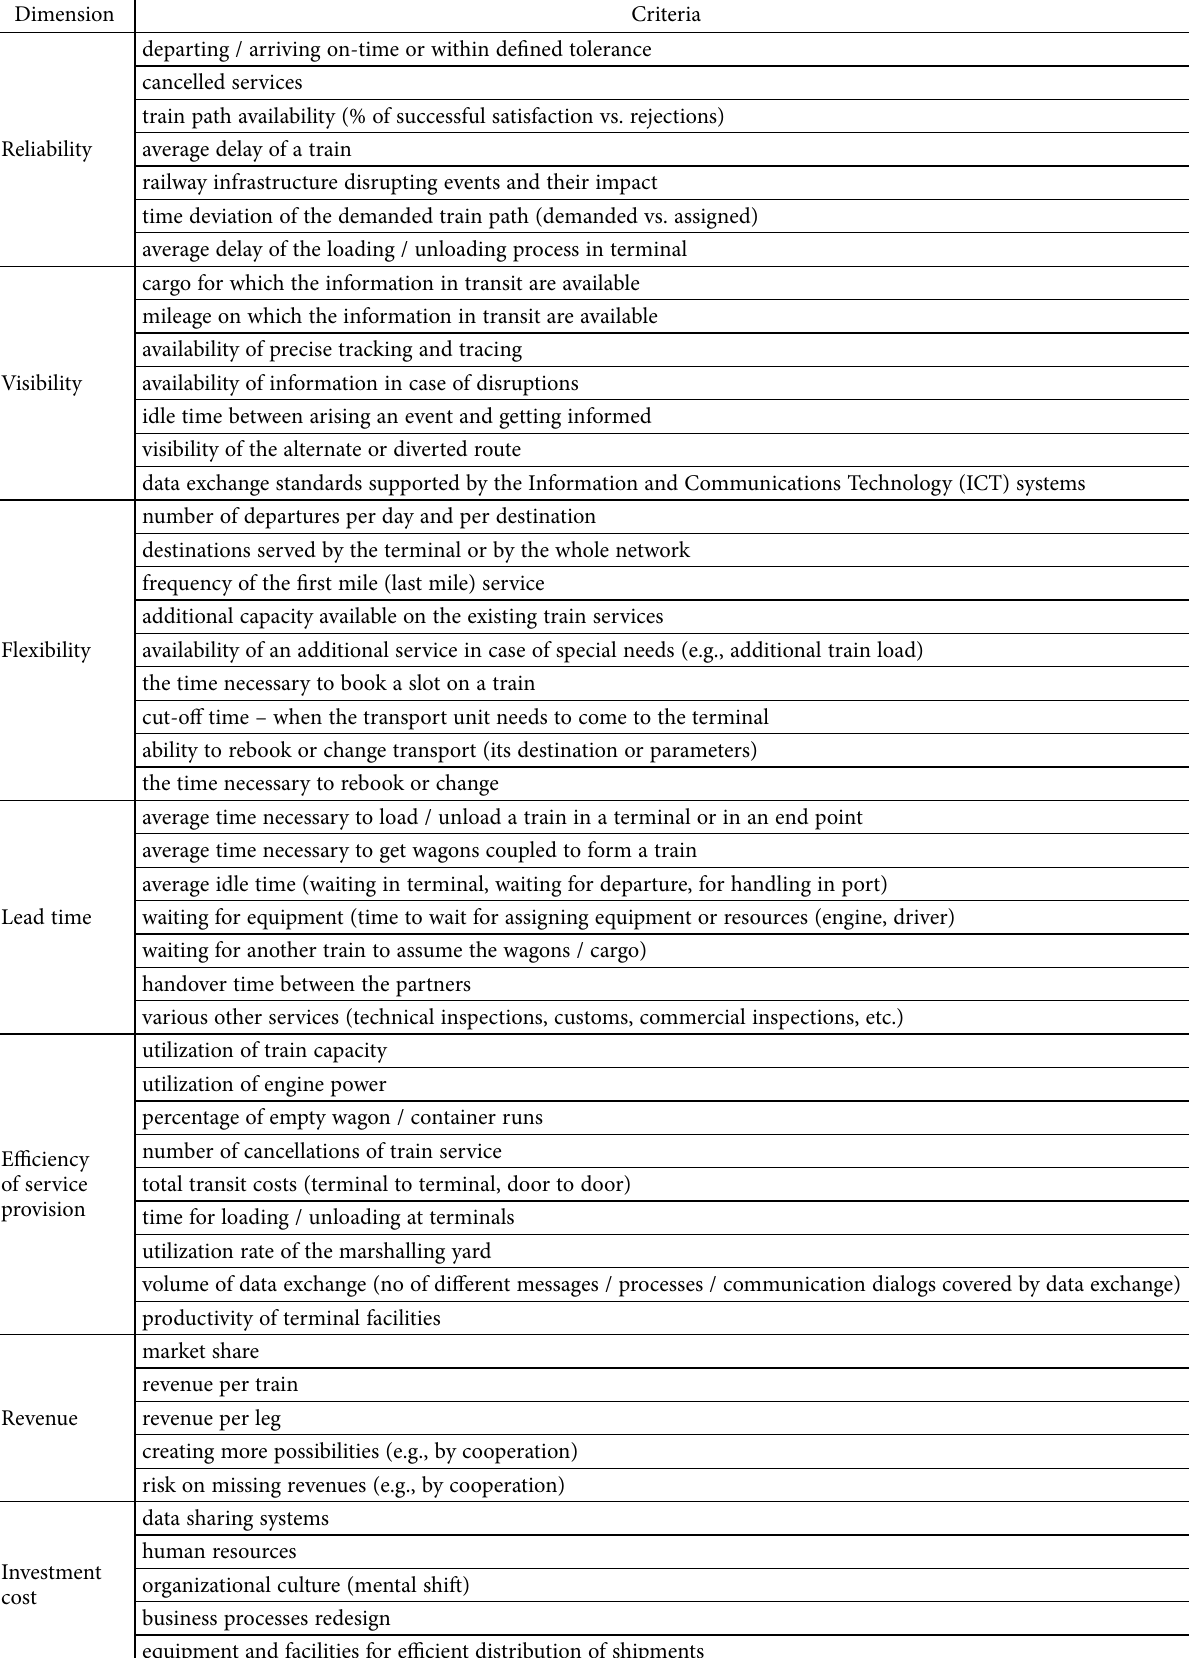
Table 3. Railway freight transport – performance evaluation factors (Smart-Rail 2016) Dimension Criteria